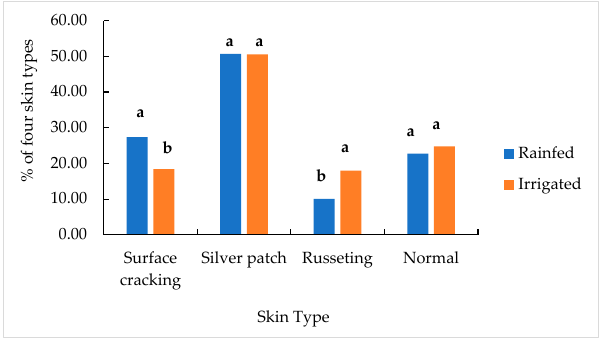
Figure 3. Percentages of the four skin types including ‘surface cracking’, ‘silver patch’, ‘russeting’, and ‘normal’ in all three years from rainfed and irrigated trials. Means not sharing a common letter in two adjacent columns are significantly different at p < 0.05 according to the Fisher LSD method.